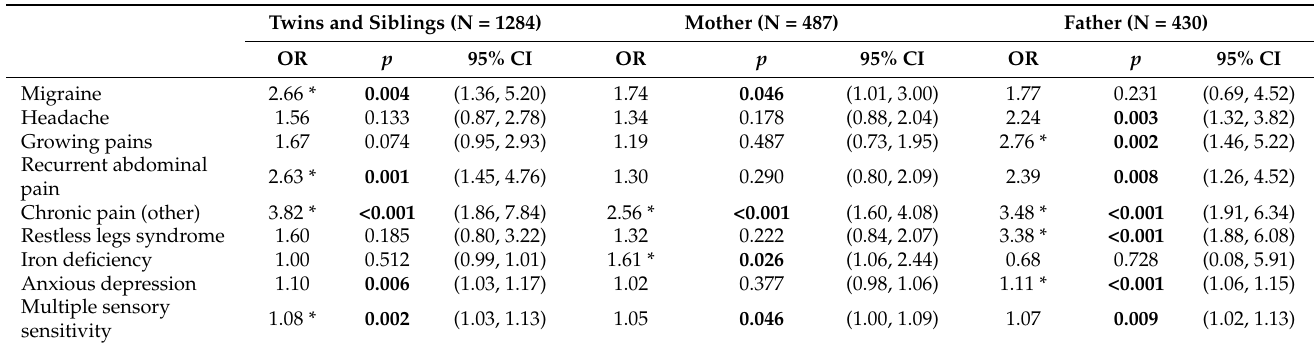
Table 9. Association between TLBP (current) and primary pain conditions and syndromes, other chronic pain conditions, restless legs syndrome, iron deficiency, anxious depression, and multiple sensory